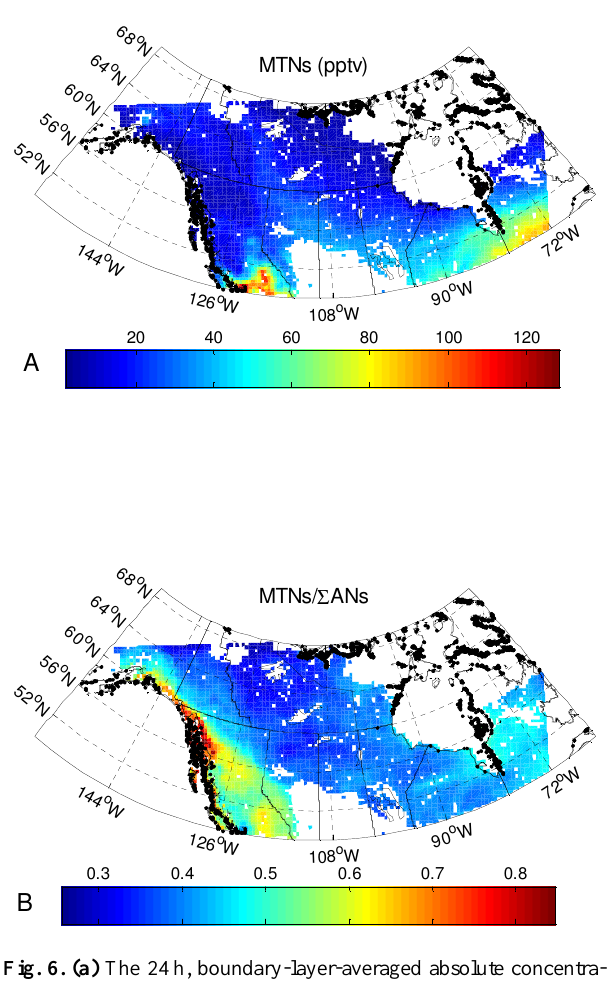
Fig. 6. (a) The 24h, boundary-layer-averaged absolute concentra- Figure 6 a) 24 h, boundary layer averaged absolute concentration of MTNs in the BASE case. b) 3 tion of MTNs in the BASE case. (b) Fractional contribution of Fractional contribution of MTNs to total oxidized nitrogen in the BASE case. 4 MTNs to total oxidized nitrogen in the BASE case.